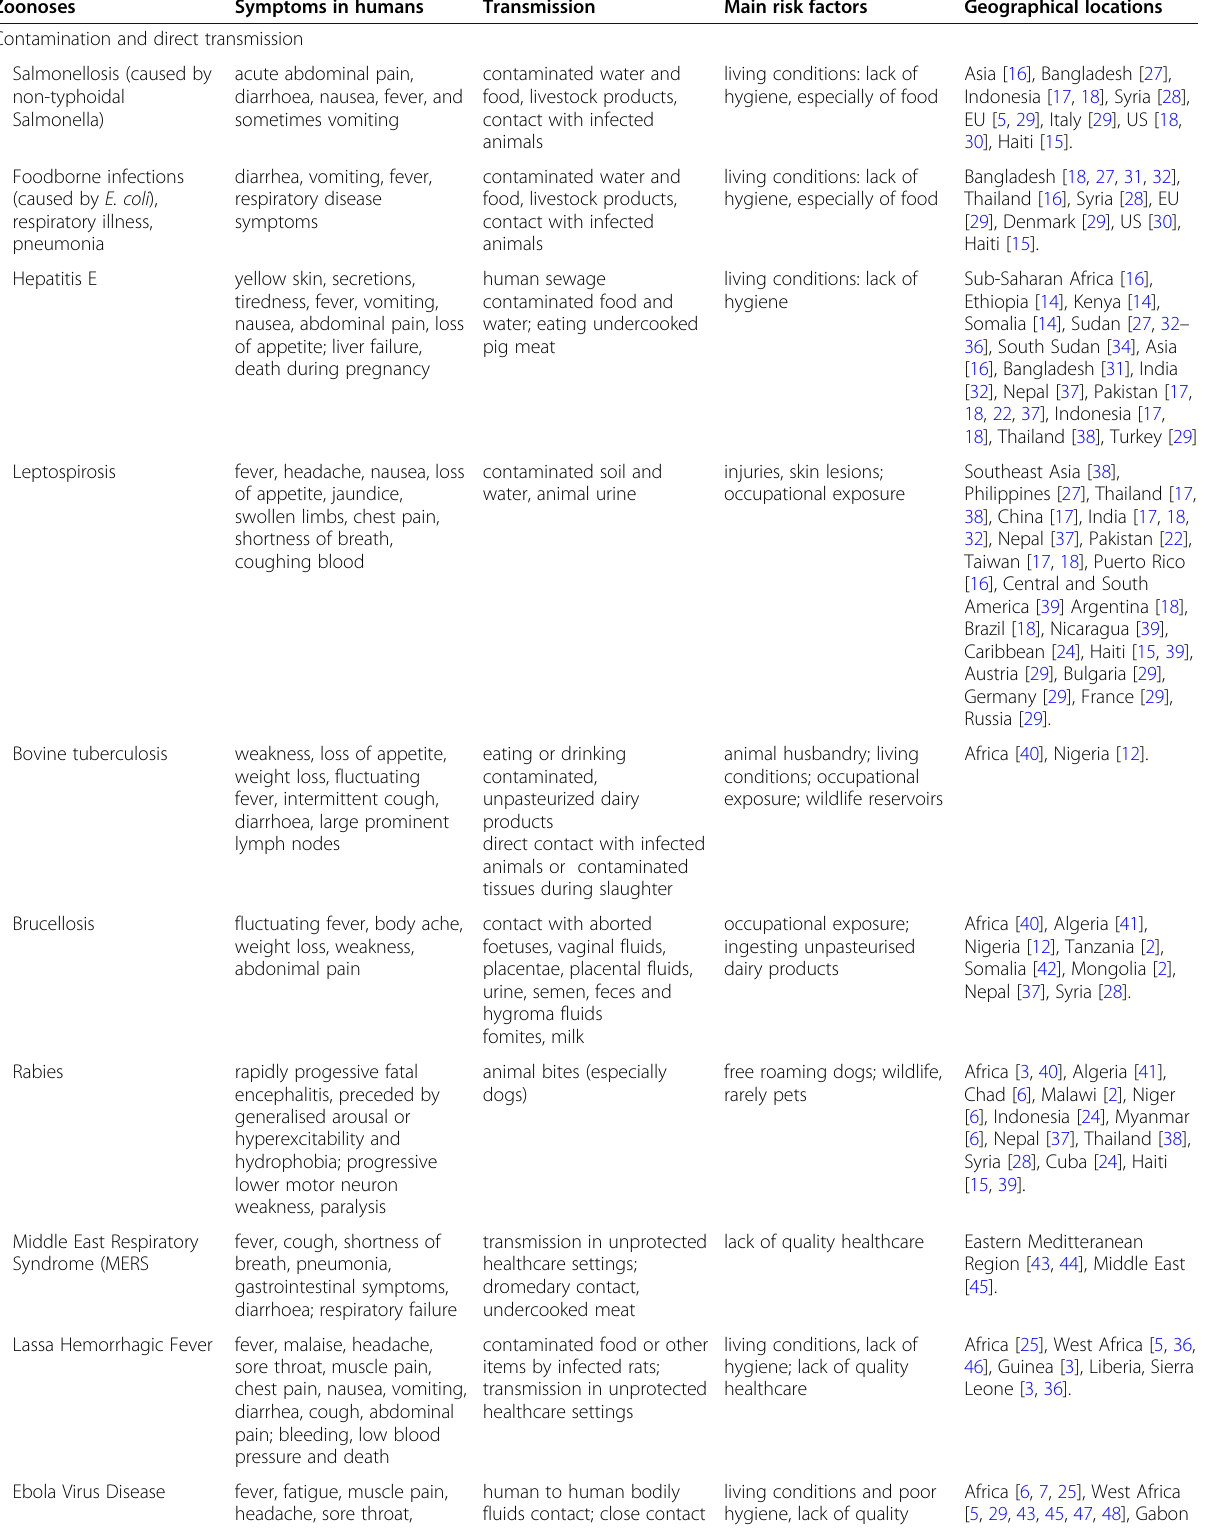
Table 1 Zoonotic diseases of concern in humanitarian emergencies and displacement (identified in the literature reviewed), disease data from: WHO communicable disease control in emergencies, A field manual [28]